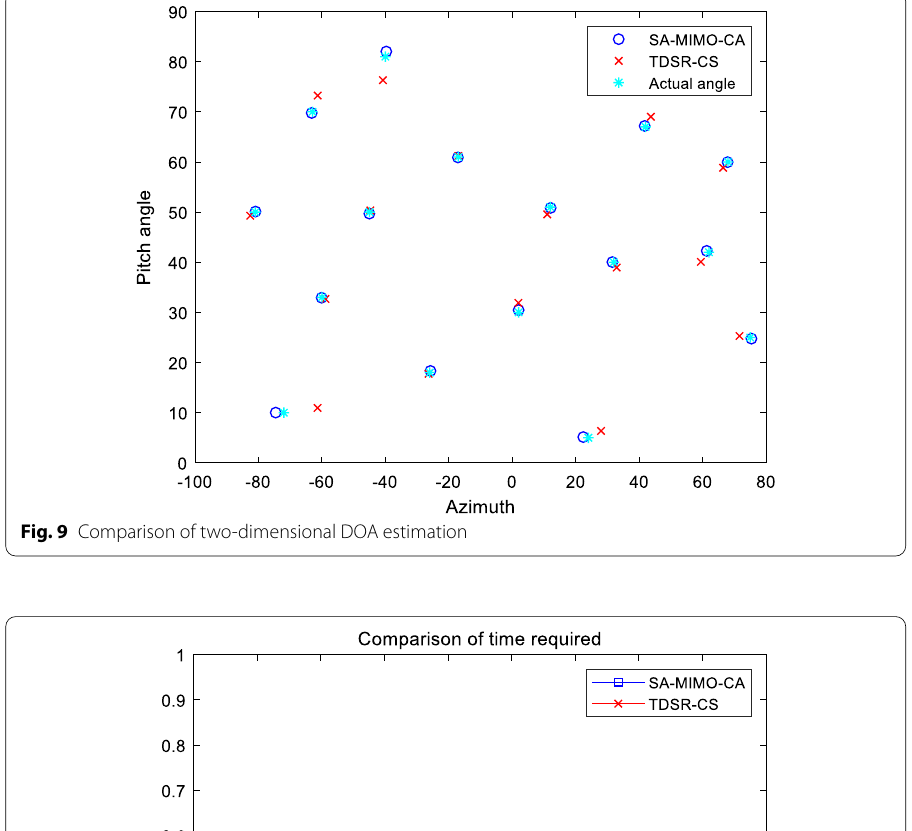
Fig. 9 Comparison of two-dimensional DOA estimation